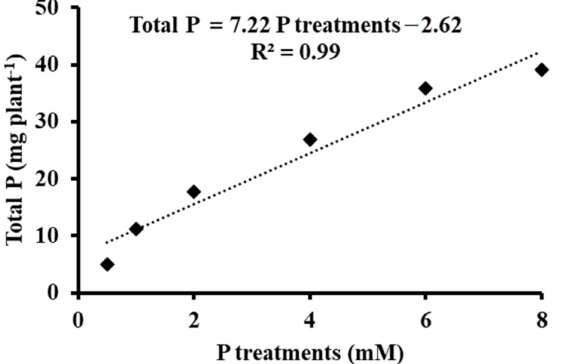
Figure 2. Relationship between P treatments (expressed in mM) and total P (expressed in mg plant − 1 ). Table 3. Effects of different P treatments on total, inorganic, organic and the organic P/inorganic P ratio in roots, shoots, pods, and seeds of green bean plants at the end of the experiment. n = 6. Means ± standard deviation within columns with different lower-case letters are significantly different at p < 0.05 (One-way ANOVA and LSD